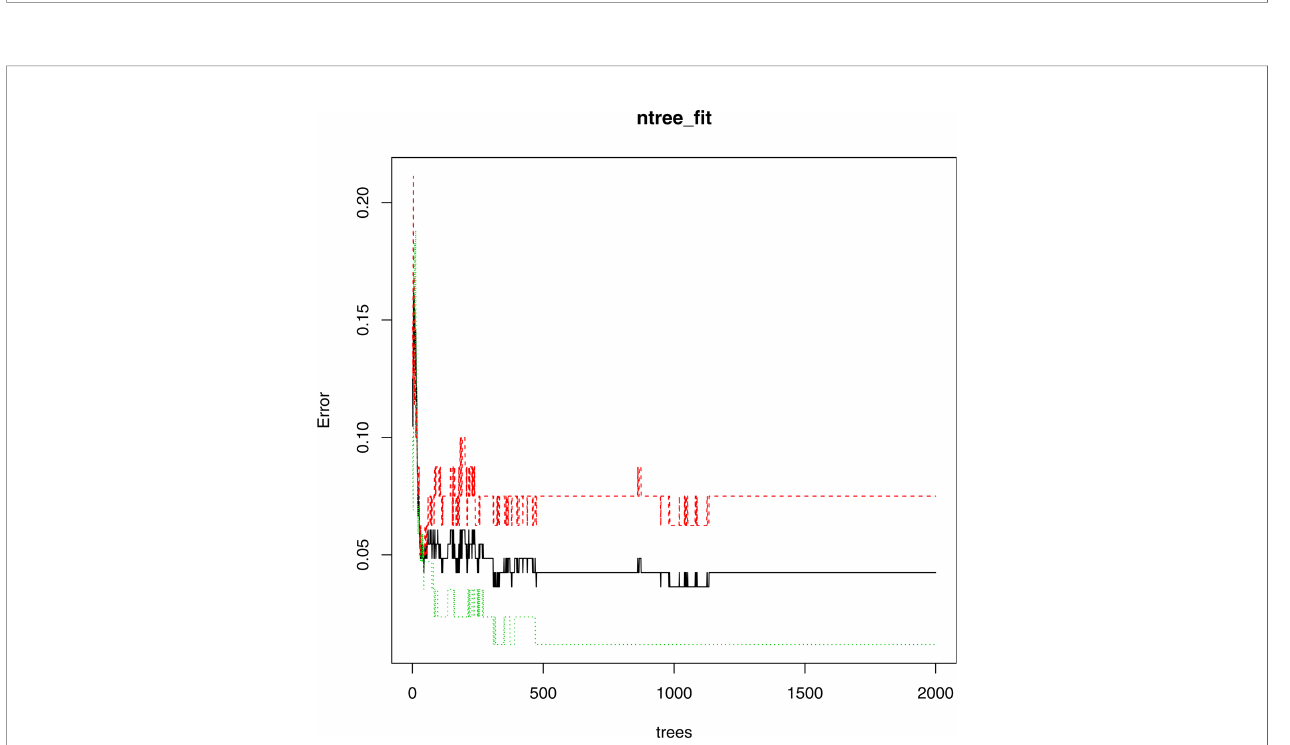
FIGURE 3 | ROC curve of prediction based on raw data.